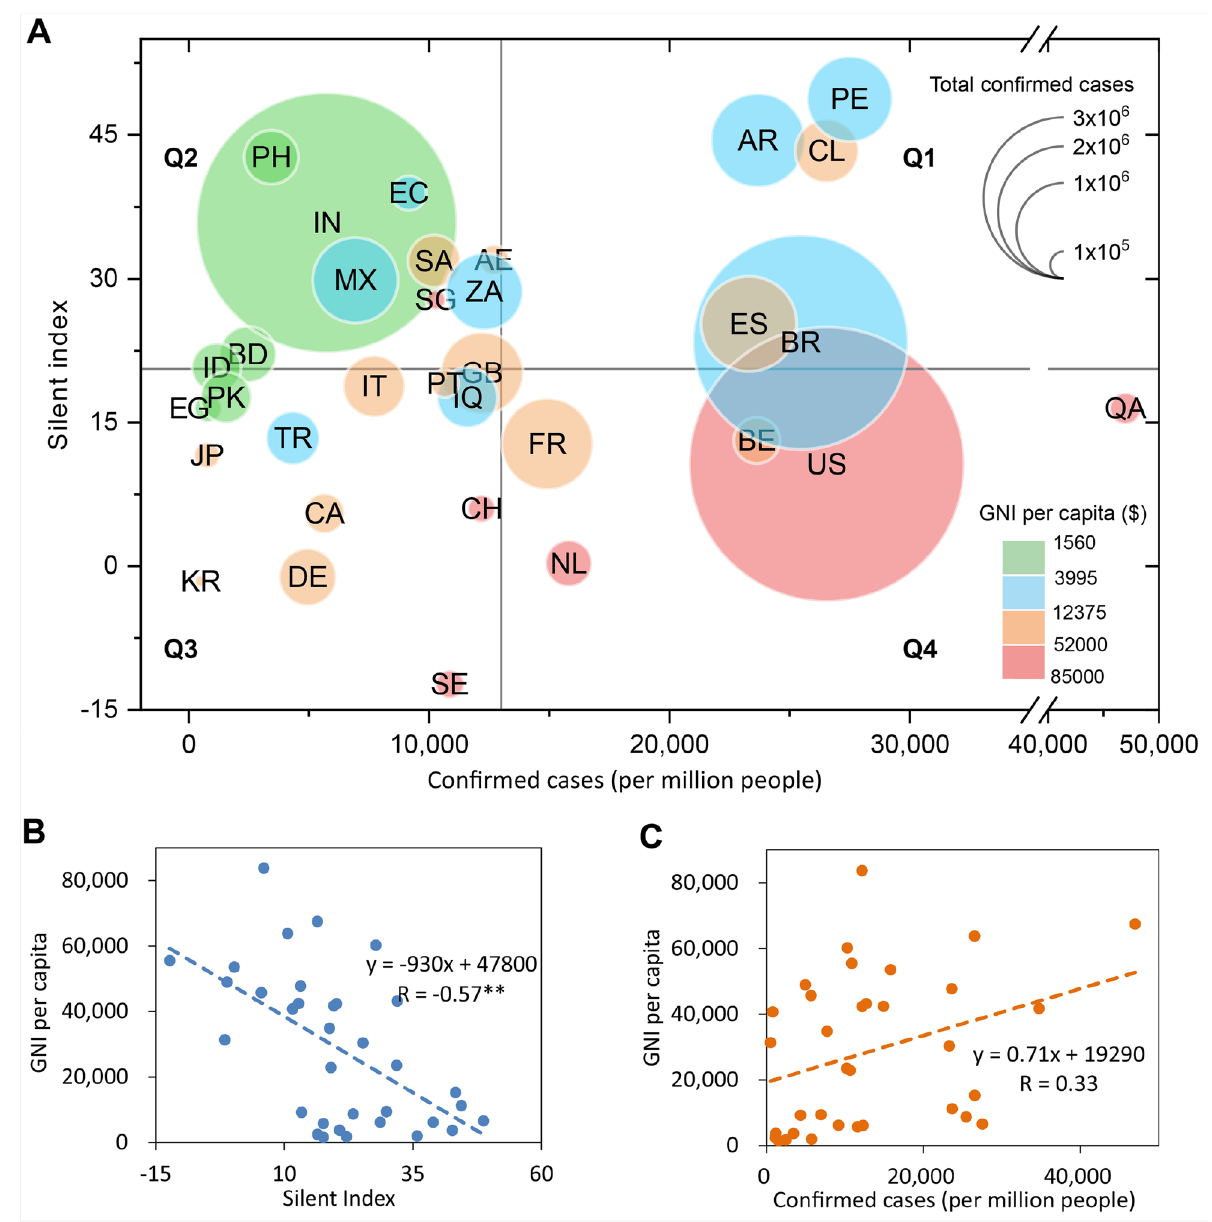
Figure 5. SI and COVID-19 infection rate in different groups of GNI per capita. ( A ) The average SI is calculated from the day with 100 cumulative COVID-19 cases to Oct. 24, 2020. The horizontal gray line represents the average value of the SI, and the vertical gray line represents the average value of the confirmed COVID-19 cases per million population. The classification of GNI per capita is based on the method of the World Bank Atlas. ( B ) The Pearson correlation coefficient (R) between SI and GNI per capita of 33 countries is -0.57, and there is a significant correlation at the 0.01 level. ( C ) Pearson correlation coefficients between COVID-19 infection rate and GNI per capita of 33 countries are not